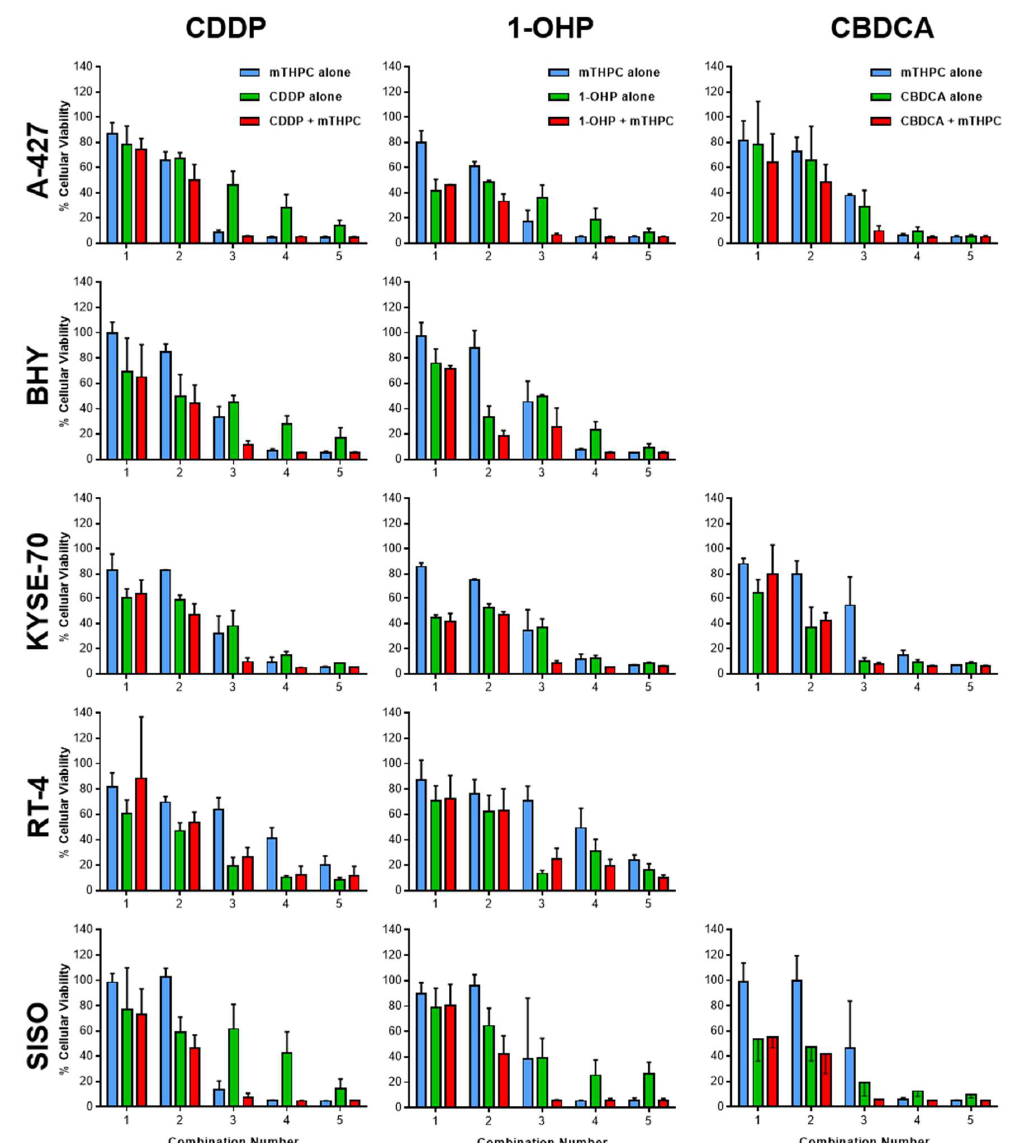
Figure 1. Loss of cellular viability after treatment with mTHPC (blue) or Pt(II) complex alone (green) or in combination (red) in various cell lines as assessed by the MTT assay 48 h after illumination with 1.8 J/cm 2 . Based on the established IC 50 values, appropriate concentration ranges for the combination studies were selected for mTHPC and the Pt(II) complexes. Two concentrations below and above the IC 50 value were used in the MTT viability assay and each of the concentrations for mTHPC or a Pt(II) complex was tested alone or a mTHPC concentration was combined with a concentration of one of the Pt(II) complex with the identical assigned combination number for each cell line. The T/C (treated over control) data from the combination studies were then used for the assessment of synergism and antagonism by the calculation of Combination Indices (CI) by the method of Chou and Talalay [23] (Figure 2). Data presented as means ± SD from at least three independent